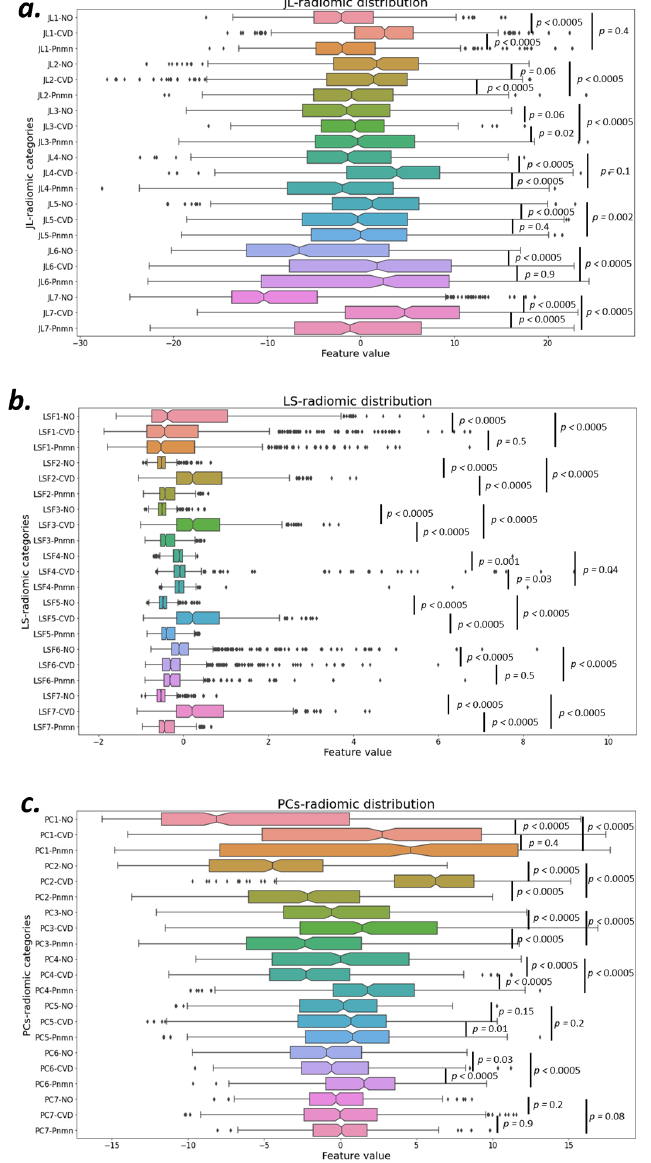
Figure 4. Classification power of each selected radiomic group to categorize COVID-19 (CVD), pneumonia (Pnmn), and no finding (NO) cases with respect to ground truth are demonstrated using Kruskal–Wallis test to show the statistical significance of the classification of conventional radiomics using three dimensionality reduction methods JL ( a ), LS ( b ), and PCA ( c